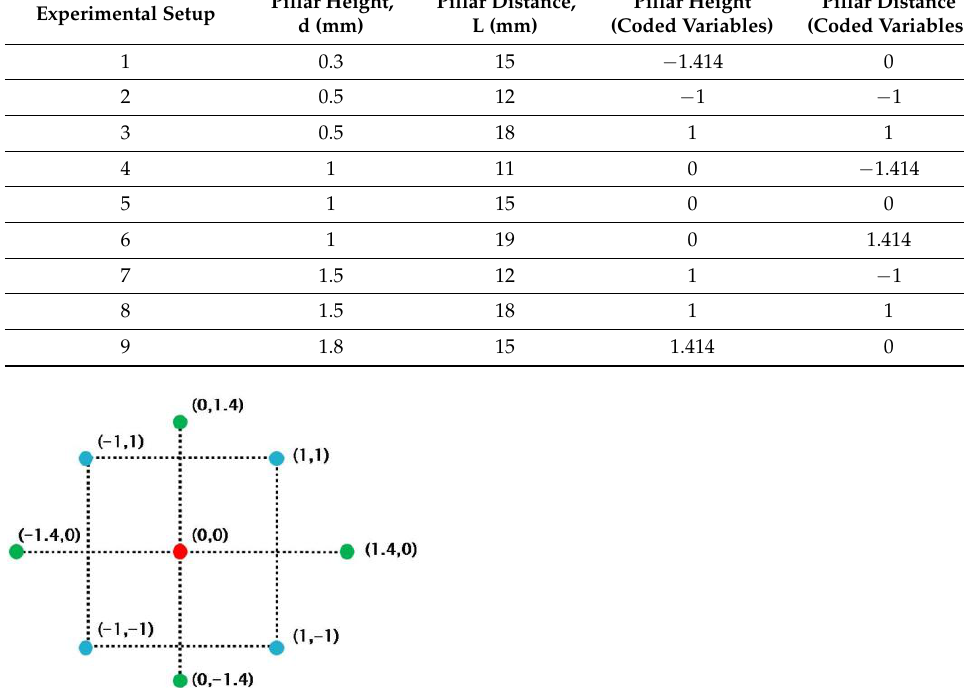
Figure 5. Central composite design to optimize pillar–pillar distance and pillar height for maximized piezoelectric activity.